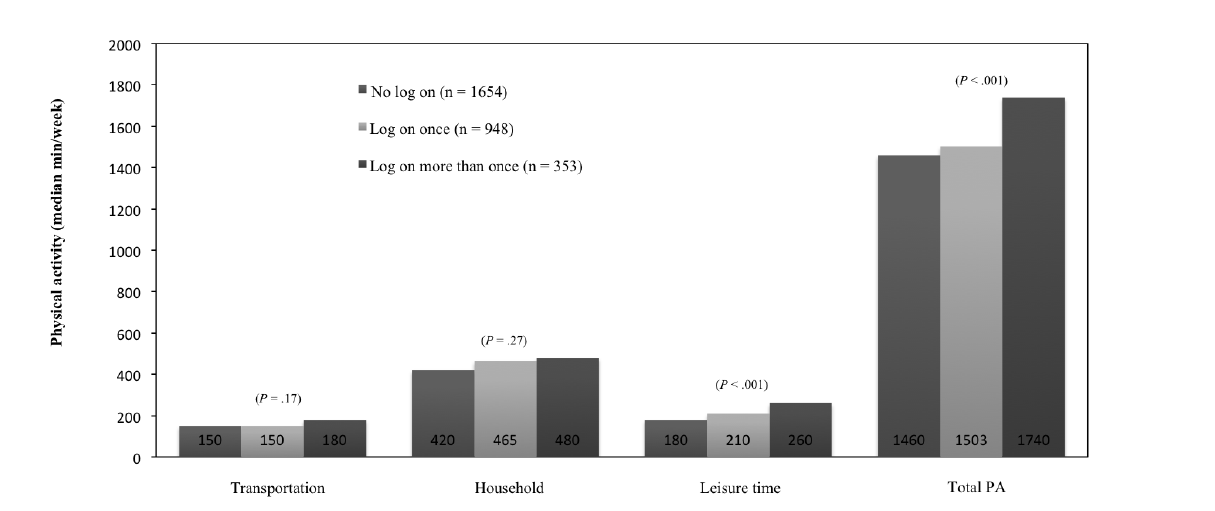
Figure 2. Physical activity (PA) in three domains and total PA at 6 months by frequency of log-ons to intervention website in the website group. Kruskal-Wallis test for differences between the groups (Denmark,